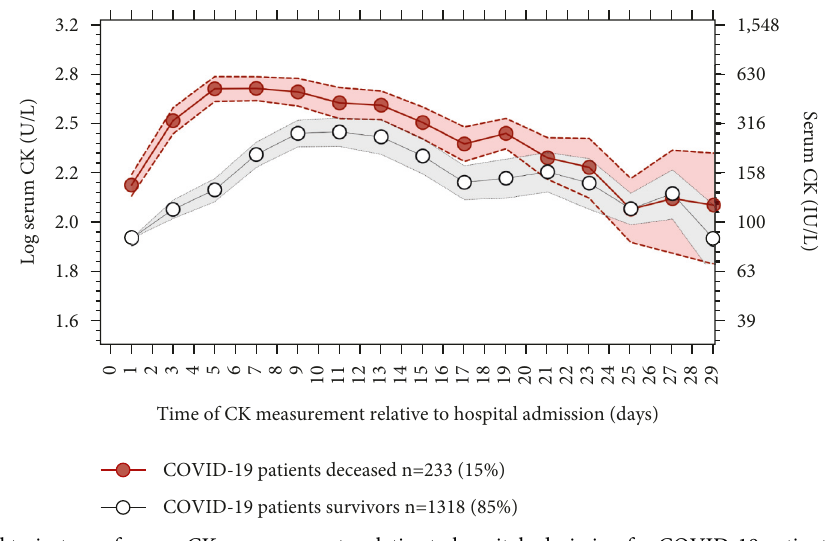
Figure 3: Longitudinal trajectory of serum CK measurements relative to hospital admission for COVID-19 patients, deceased vs survivors. Red (deceased) and black (survivors) correspond to means of log serum CK concentrations (a) or CK concentrations in IU/L (b) for COVID-19 deceased patients versus survivors; 95% confidence intervals are represented in shaded